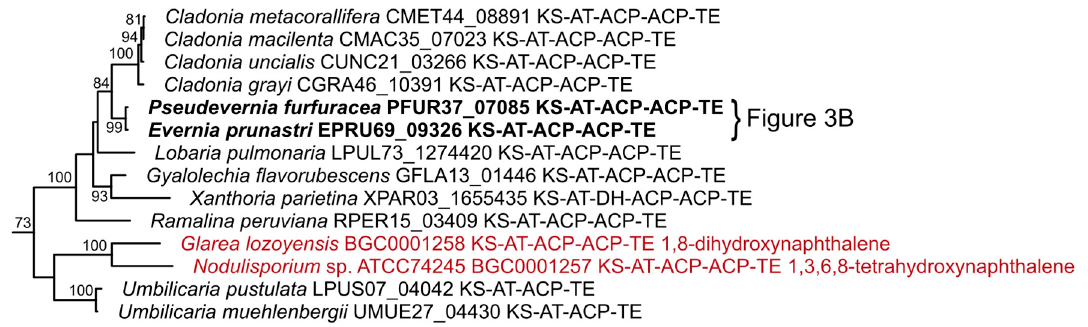
Figure 8. Supported clade containing PKSs from dihydroxy and tetrahydroxy naphthalene producers (MIBiG-ID BGC0001257, BGC0001258). For the complete KS tree see Figure S1.